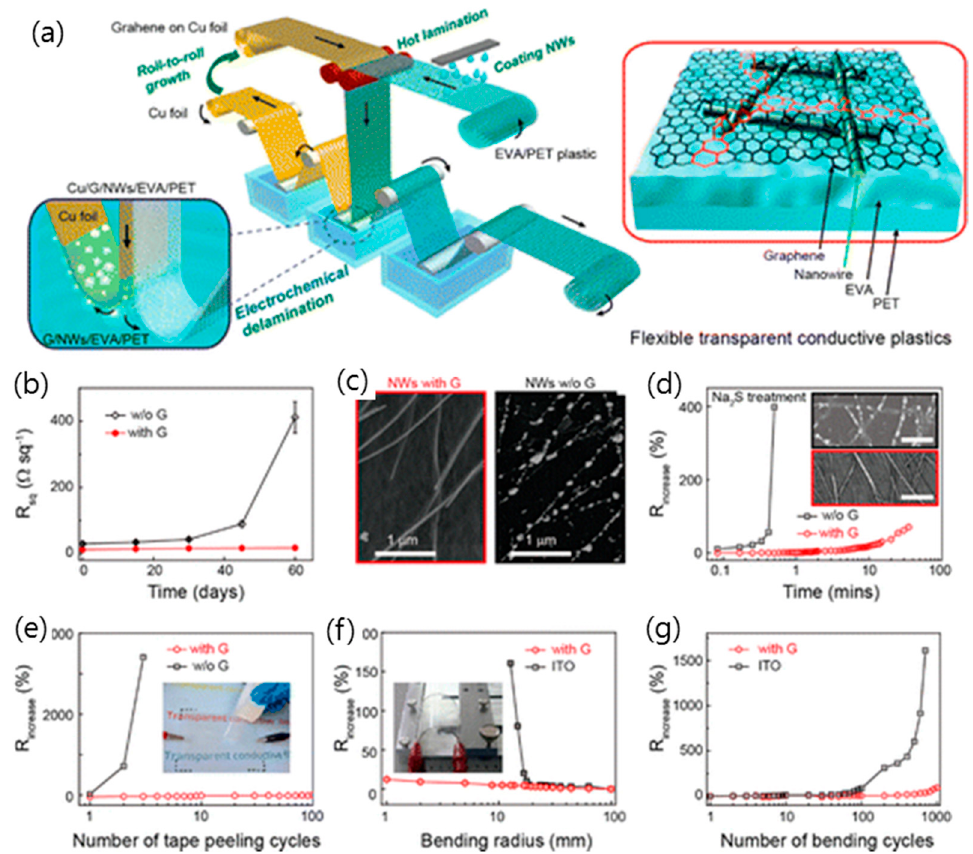
Figure 8. ( a ) Schematic and structure of graphene and metal nanowire hybrid films produced by a continuous roll-to-roll process. ( b ) The durability of graphene and metal nanowire hybrid transparent electrodes. Changes in sheet resistance of pure AgNW films and the graphene/AgNW hybrid films exposed in air at room temperature for 2 months. ( c ) SEM image of the graphene/AgNW hybrid film and pure AgNW films exposed in air for two months, revealing that AgNWs without the protection of graphene were oxidized to break. ( d ) Changes in sheet resistance of pure AgNW films and the graphene/AgNW hybrid films under the attack of aqueous Na 2 S (4 wt.%). (Inset) Morphologies of AgNWs with or without the graphene coverage attacked for 30 s, respectively. Scale bar: 1 μ m. ( e ) Variations in sheet resistance of pure AgNW films and graphene/AgNW hybrid films as a function of the number of cycles of repeated peeling by 3M Scotch tape. ( f ) Variations in sheet resistance versus bending radius for the hybrid transparent plastic electrodes and ITO films on 150 µ m thick PET. ( g ) Variations in sheet resistance of the hybrid transparent plastic electrodes and ITO films on PET as a function of the number of cycles of repeated bending to a radius of 20 mm. Reproduced with the permission of Reference [54]. Copyright 2015, American Chemical